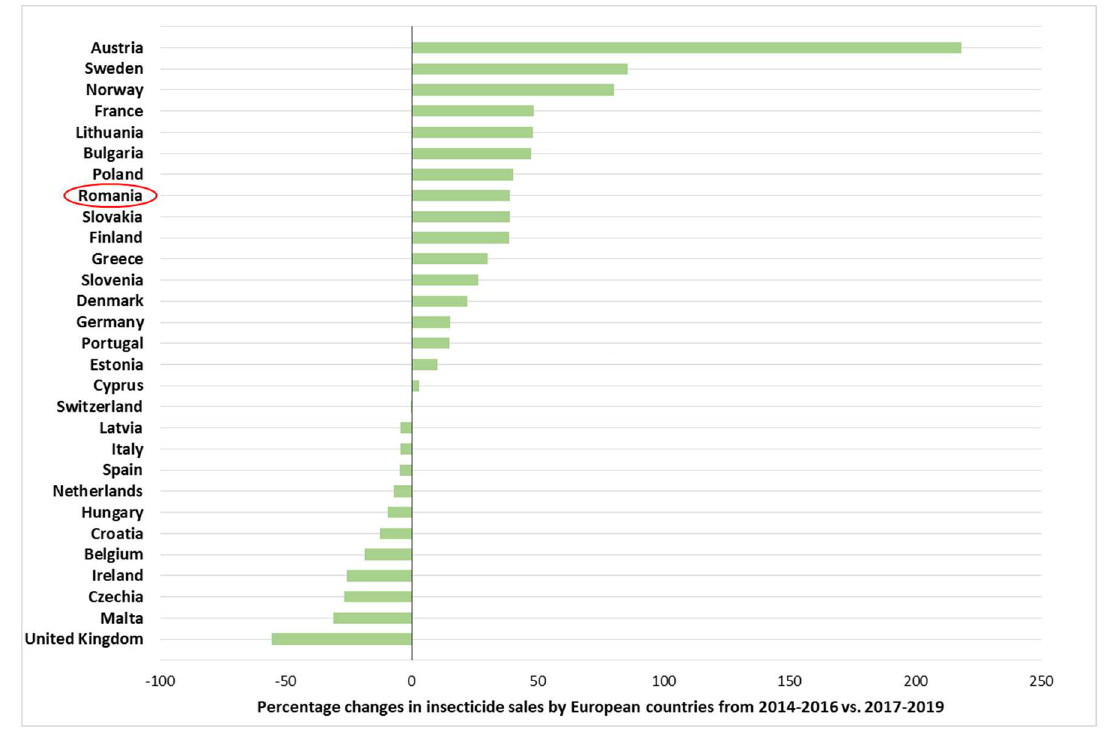
Figure 5. Percentage changes in insecticide sales by European countries from 2014–2016 vs. 2017–2019 (the presented graphic is based on data obtained from EUROSTAT database [101]). Germany, Italy and Spain are the top insecticide users from the European countries, while France, Ukraine and Romania use most of pyrethroids for pest control (Figure 6) [102].